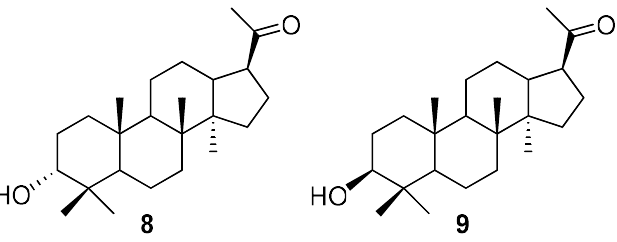
Figure 5. The structures of 8 and 9 .